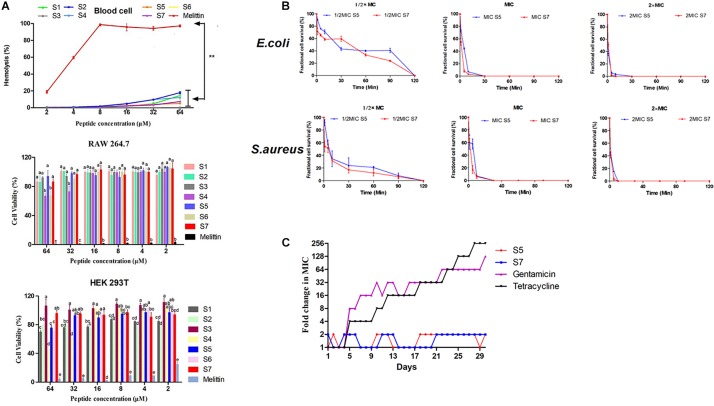
Cell toxicity of the peptides against erythrocytes, RAW264.7 and HEK 293T. Statistically significant differences are noted with different letters (P < 0.05) and ** represents significant difference compared with Melittin (P <0.01) (A); Fractional microbial survival of Escherichia coli ATCC 25922 and Staphylococcus aureus ATCC 29213 treated with S5 and S7 (B); Resistance development in the presence of sub-MIC concentration of S5, S7, gentamicin, and tetracycline (C).